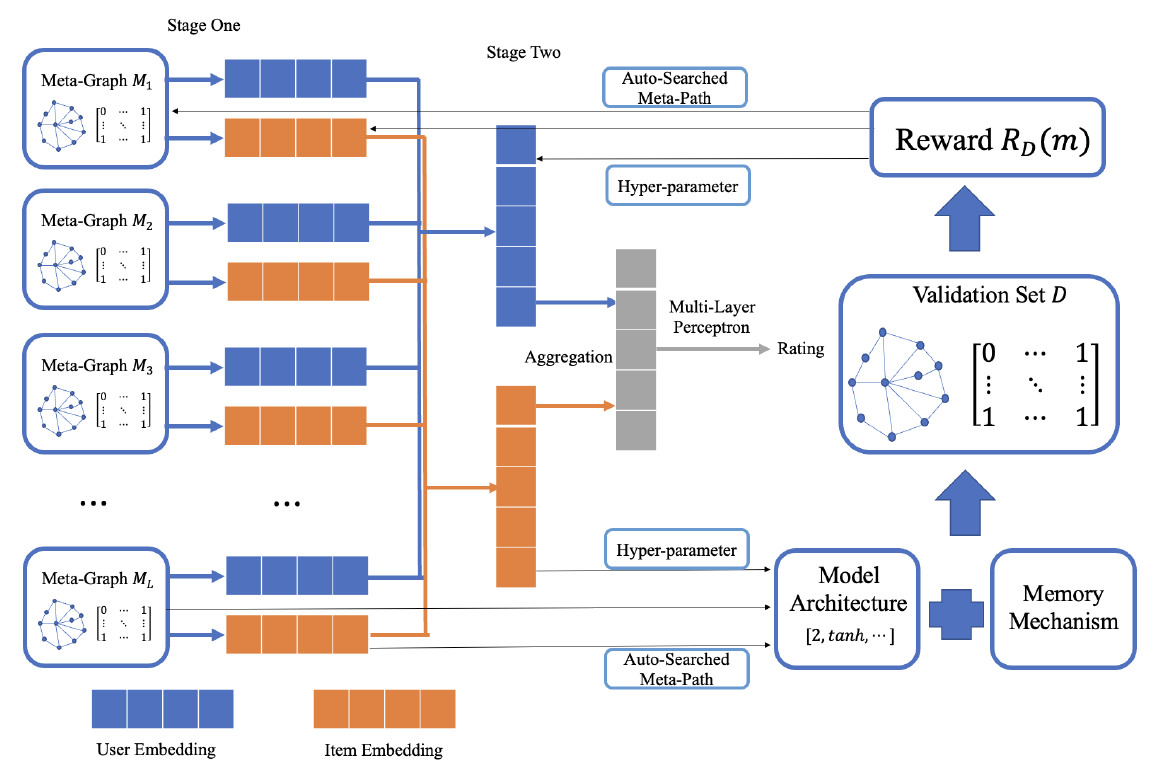
Figure 1. Two-stage recommendation model with heterogeneous information network. The model can be divided into two stages. In the first stage, we use graph neural networks to embed nodes into low-dimensional space. In the second stage, we fuse the user embedding and item embedding; then, we employ deep neural network to make